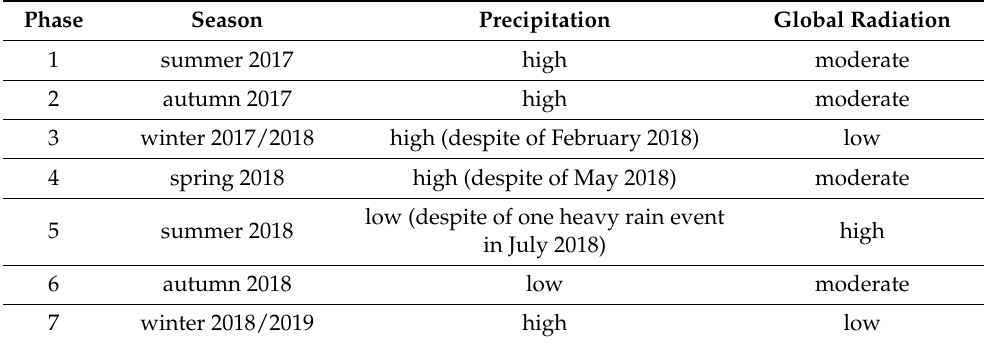
Table 3. Rough description of precipitation and global radiation during the seasons of the semi-field experiment. Graphs of the weather conditions during the experiments are given in Supplementary Information SI S5. Phase Season Precipitation Global